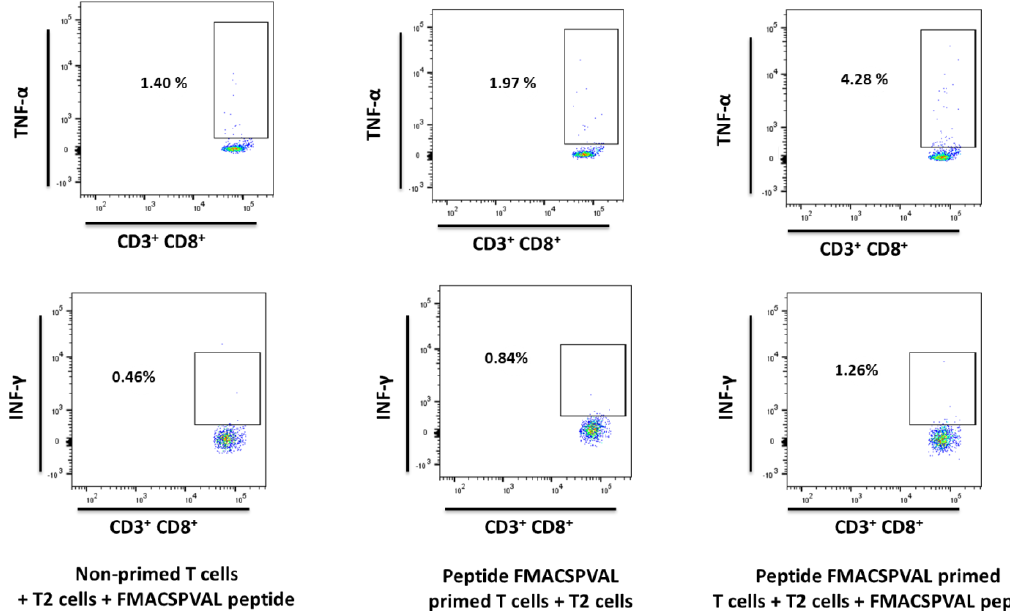
Figure 6. Intracellular flow cytometry staining (HD 3026, E:T ratio 1:10) primed with peptide FMACSPVAL. The ability of FMACSPVAL-specific CD8 + T cells to secrete the cytokines IFN- γ and TNF- α after stimulation was evaluated by intracellular flow cytometry staining. A non-primed T cell group and unloaded T2 cell group served as negative controls. Exemplary flow cytometry plots of positive responses are shown. Percentages of IFN- γ + and TNF- α + cells after peptide-stimulation were analyzed and compared with negative control samples. T cells were gated on CD3 + CD8 + cells. ELAGIGILTV-specific CD8 + T cells were used as a positive control to measure the IFN- γ and TNF- α secretion ability. The level of IFN- γ production and the level of TNF- α production by ELAGIGILTV-specific CD8 + T cells co-cultured with ELAGIGILTV-loaded T2 cells increased compared to the negative control (Figure 7). To determine whether peptide-specific T cells affected SOX11-positive target cells, we performed a cytotoxicity assay using Granta-519 cells as a target (Figure 8). Granta-519 cells were killed by FMACSPVAL-primed T cells; however, they were not killed by non-primed T cells. Taken together, the peptide FMACSPVAL seemed to be presented by tumor cell lines and was recognized by T cells specific to the HLA-A*0201-restricted FMACSPVAL peptide epitope.